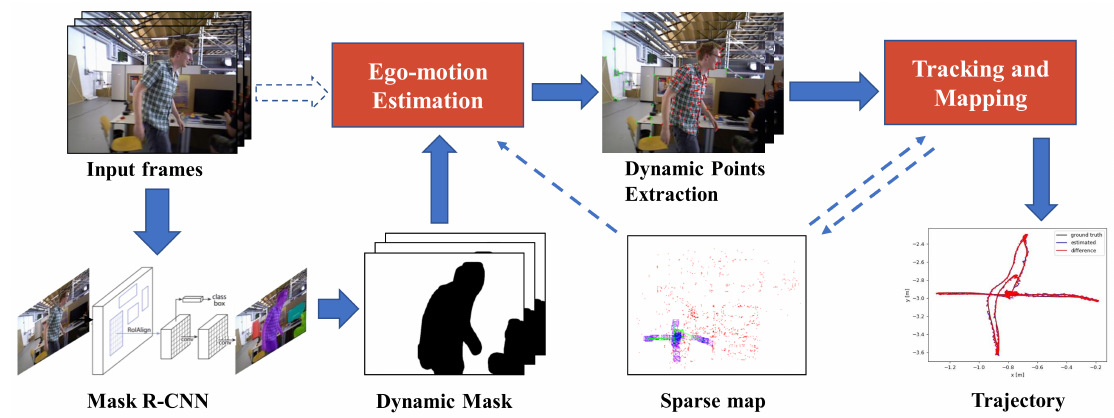
Figure 2. Overview of our proposed method. Input frames are segmented by the Mask R-CNN network, and then the feature points that fall in the initially assumed dynamic content are discarded for ego-motion estimation. The static feature points left are fed into the SLAM algorithm for tracking and mapping after dynamic feature points are discarded.